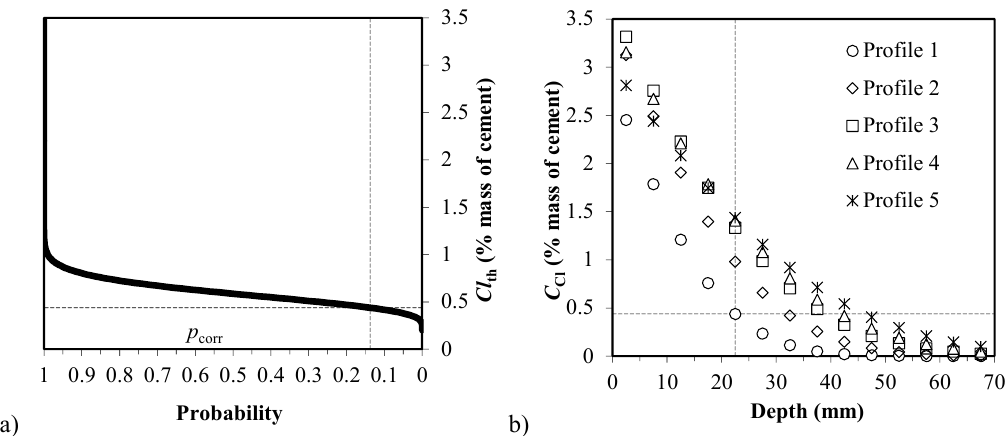
Figure 1. Cumulative distribution function of the critical chloride content (a) and imaginary chloride profiles measured on a RC structure (b).